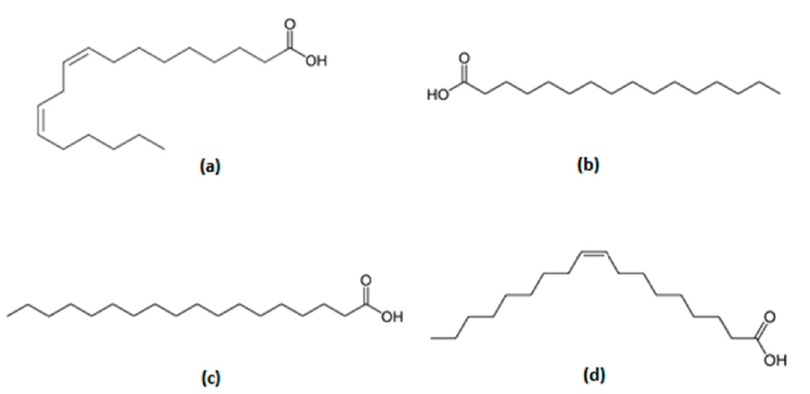
Figure 6. Chemical structure of ( a ) linoleic acid, ( b ) palmitic acid, ( c ) stearic acid, and ( d ) oleic acid as main constituents of the B. excelsa oil.